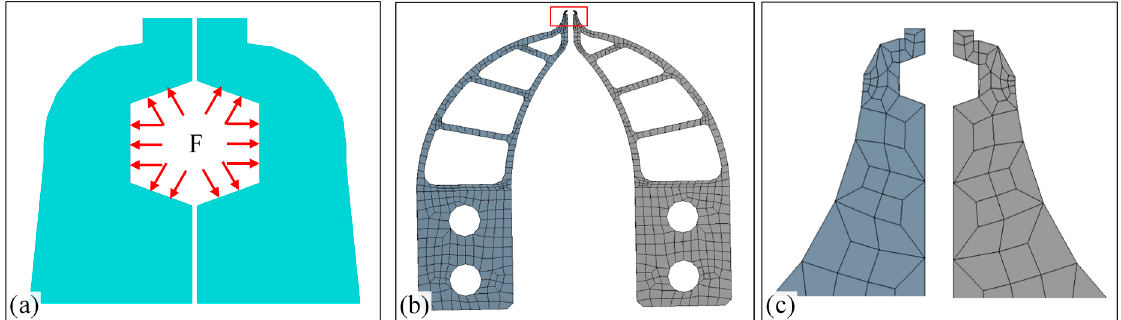
Figure 6. Force and finite element model for micro-gripper’s tip: ( a ) Force model, where F represents the force exerted by the wire on the inner edge of the enveloped region; ( b ) Finite element model of micro-gripper’s tip; ( c ) Locally enlarged finite element model corresponding to the area marked by a red box in subfigure ( b ).